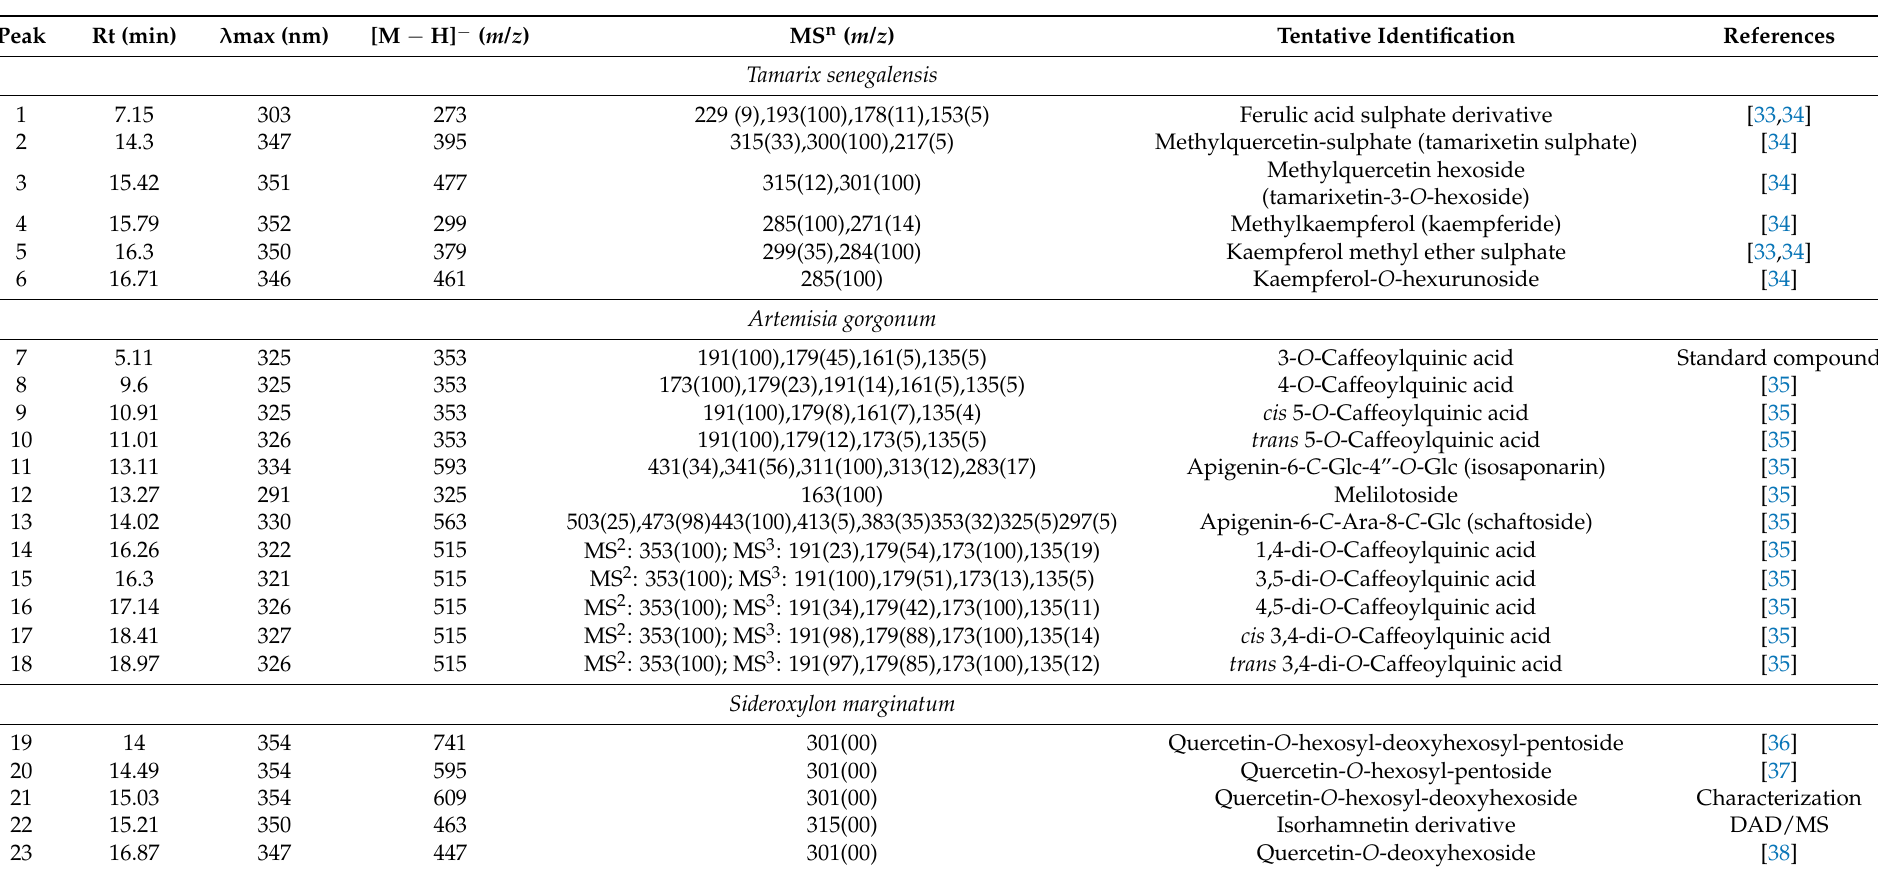
Table 2. Retention time (Rt), wavelengths of maximum absorption in the visible region ( λ max), mass spectral data, and identification of the phenolic compounds present in the ethanolic extracts and infusion preparations of the T. senegalensis , A. gorgonum , and S. marginatum